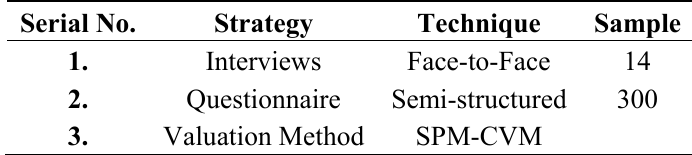
Table 1. Methodology. Source: Akujuru and Ruddock